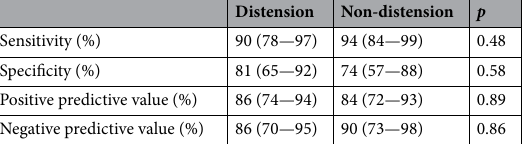
Table 4. Comparison of diagnostic performance for serosal invasion. Data presented as percentages and range in parenthesis.